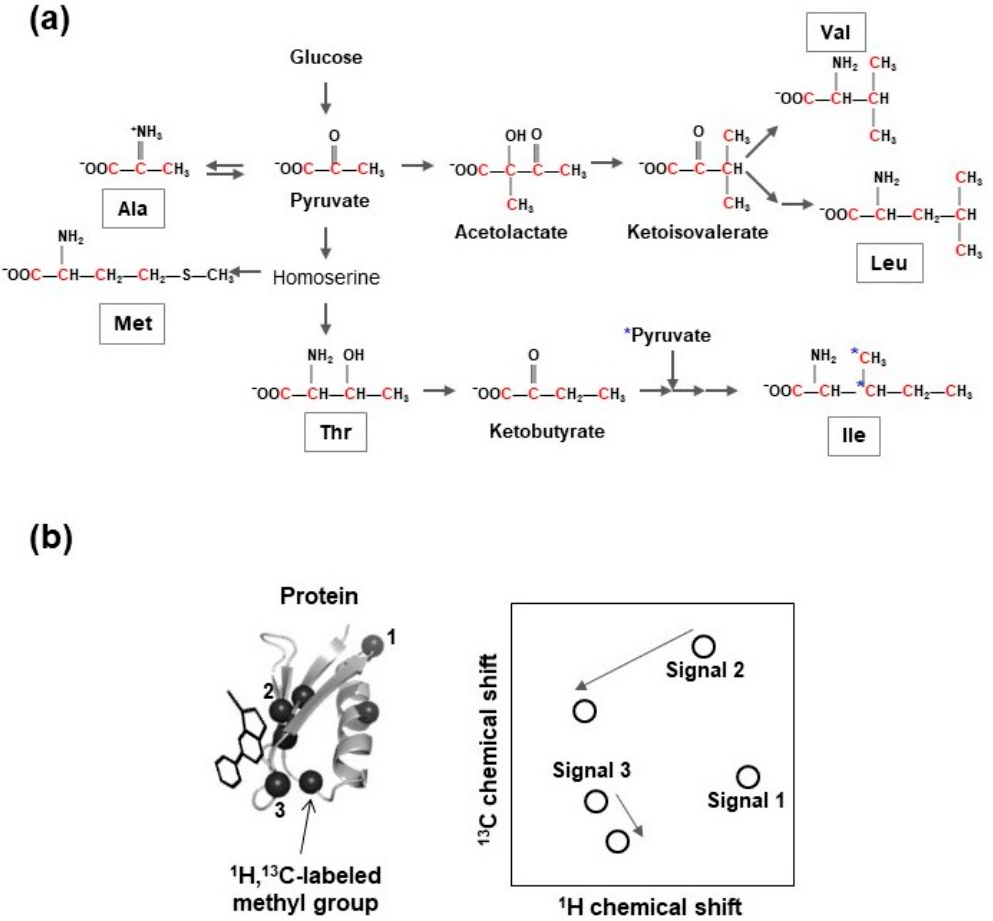
Figure 4. ( a ) Schematic diagram of amino acid biosynthesis and methyl group-specific 13 C-labeling. Ketobutyrate and ketoisovalerate, precursors of isoleucine and valine/leucine, respectively, are utilized for methyl group-selective 13 C-labeling of isoleucine, valine, and leucine residues. The red colored carbons are from same origin in metabolism. The blue asterisks denoted on the isoleucine indicate the carbons from pyruvate; ( b ) Chemical shift perturbation method as a protein-based NMR approaches for SBDD studies. Black spheres on the protein, represented with ribbon diagram, indicate position of 13 C-labeled methyl groups. Ligand is represented with stick diagram. Numbers on the spheres correspond to each 1 H- 13 C correlation NMR signal on the right panel. Chemical shift perturbation induced by interaction with ligand is indicated by gray arrows.